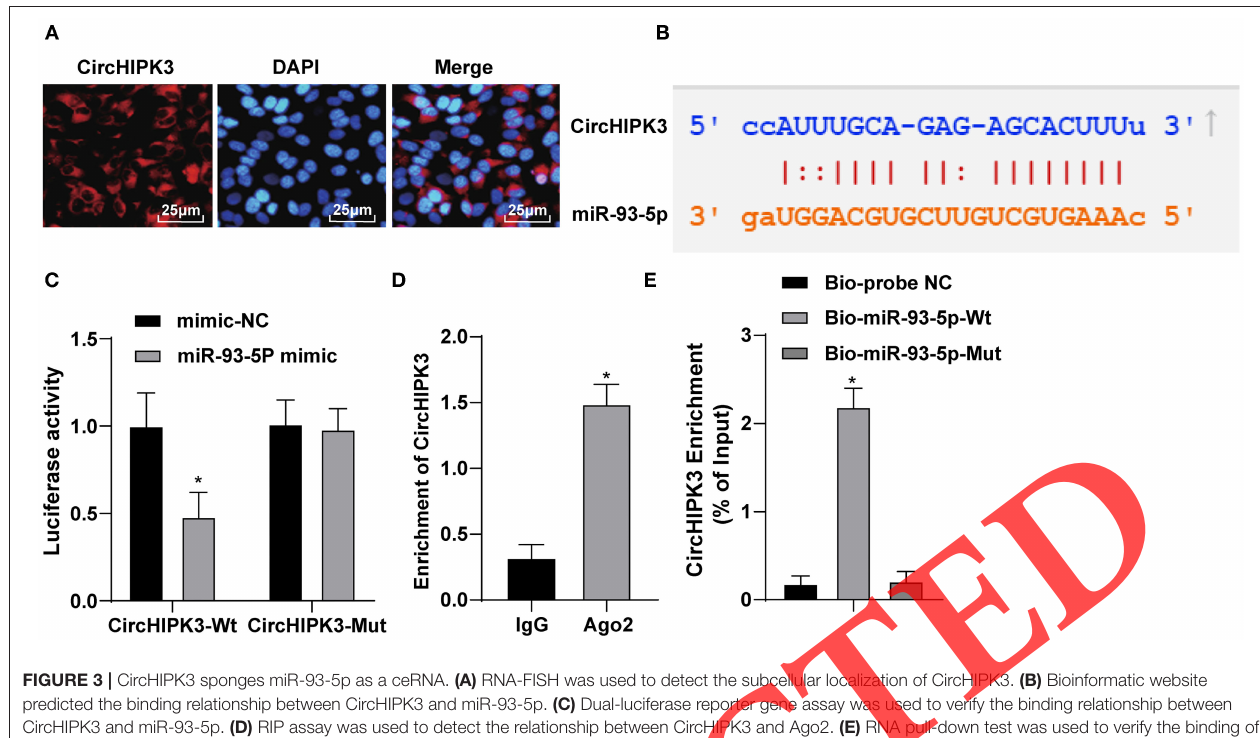
+ agomiR-NC group, and oe-CircHIPK3 + miR-93-5p